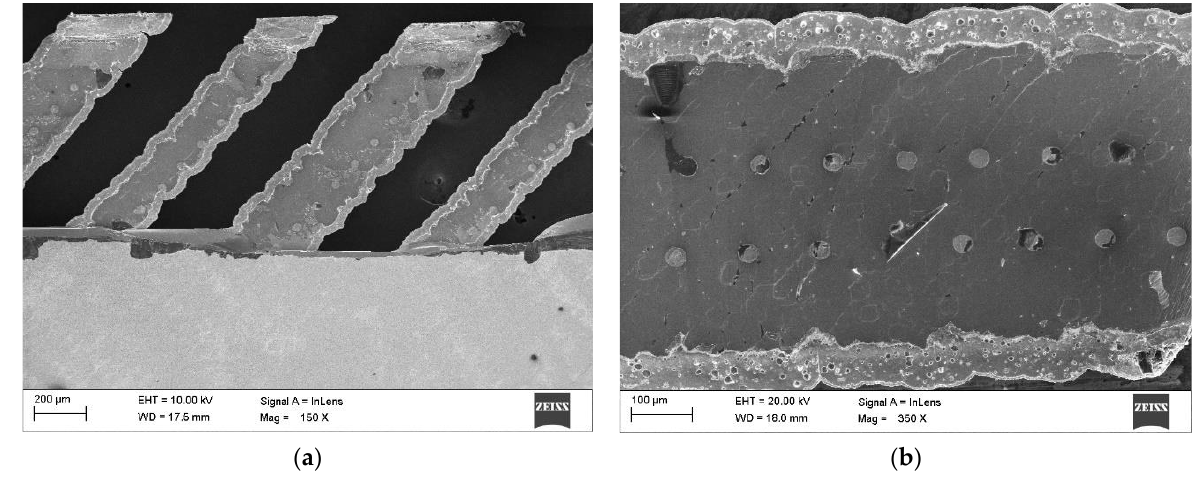
Figure 7. Rear surface of Maxeon Ne3 with visible connectors in the lower part.